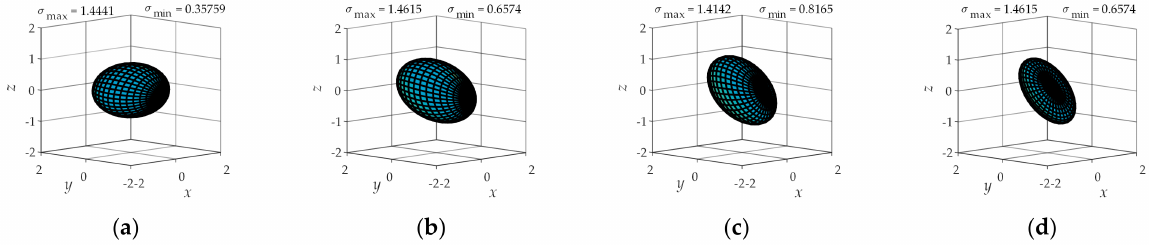
Figure 16. Manipulability ellipsoid of 2 P a 1 P 3 R a in the 30 ◦ coronal plane. ( a ) β = 30 ◦ ; ( b ) β = 60 ◦ ; ( c ) β = 90 ◦ ; ( d ) β = 120 ◦ .